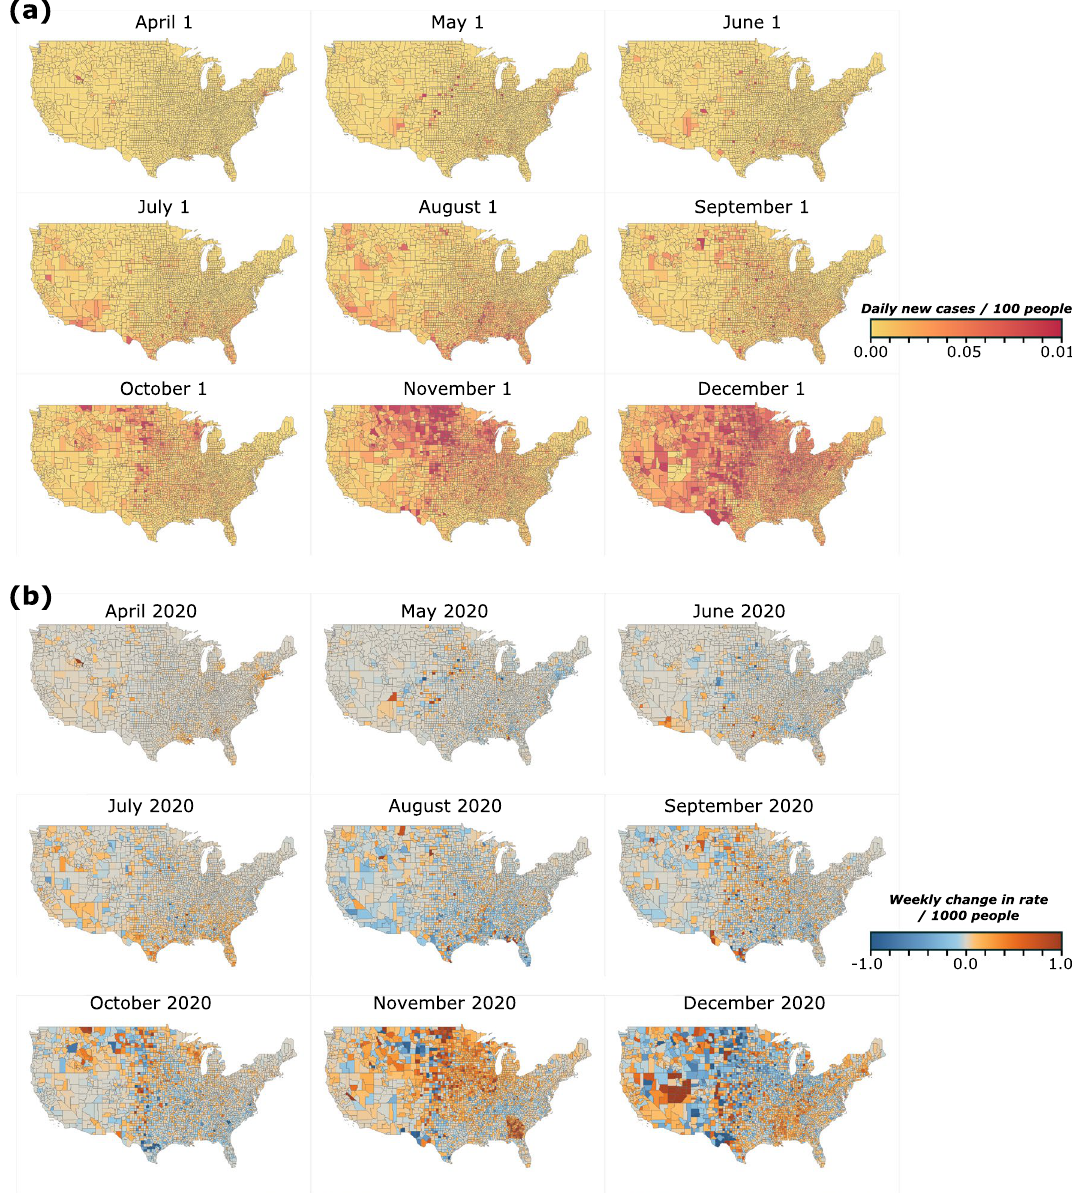
Figure 1. Evolution of COVID-19 spreading in the continental US. ( a ) Average daily rate of new infections from April to December 2020 for the first week of the month at the county level. ( b ) Maps of the quantity X T ( i ), which corresponds to the change in the daily rate of infections between two consecutive weeks in the beginning of each month. Red color indicates an increase compared to the previous week and blue color indicates that the rate